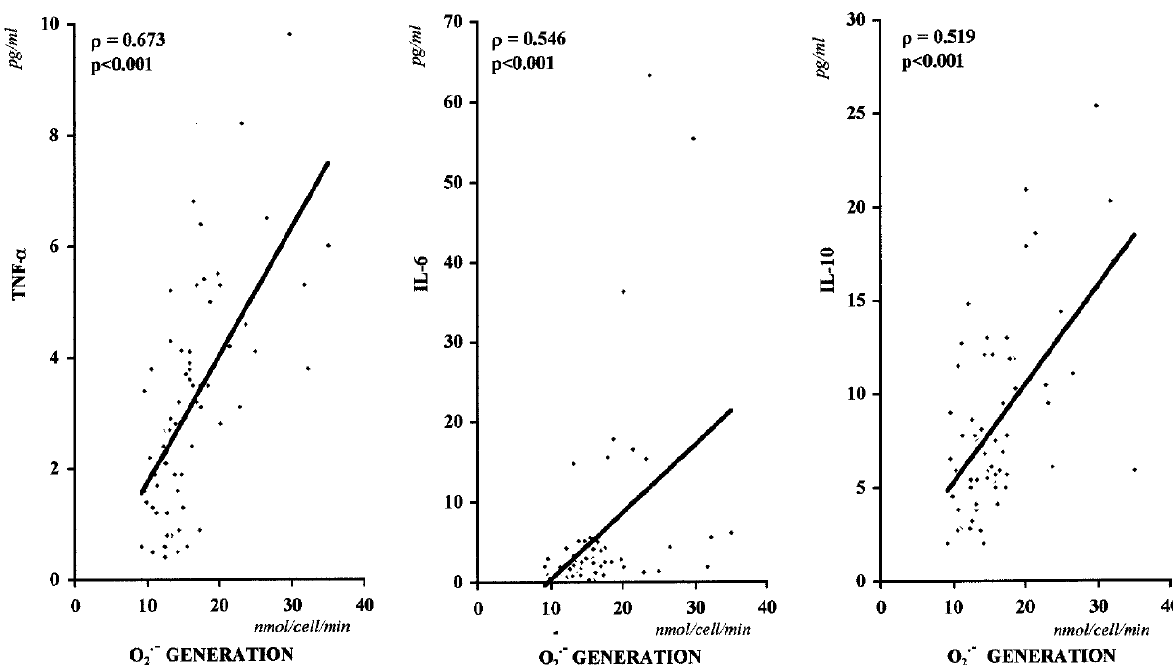
FIG. 3. Correlations between generation of O 2.– and TNF- a , IL-6, IL-10 serum concentrations in patients with